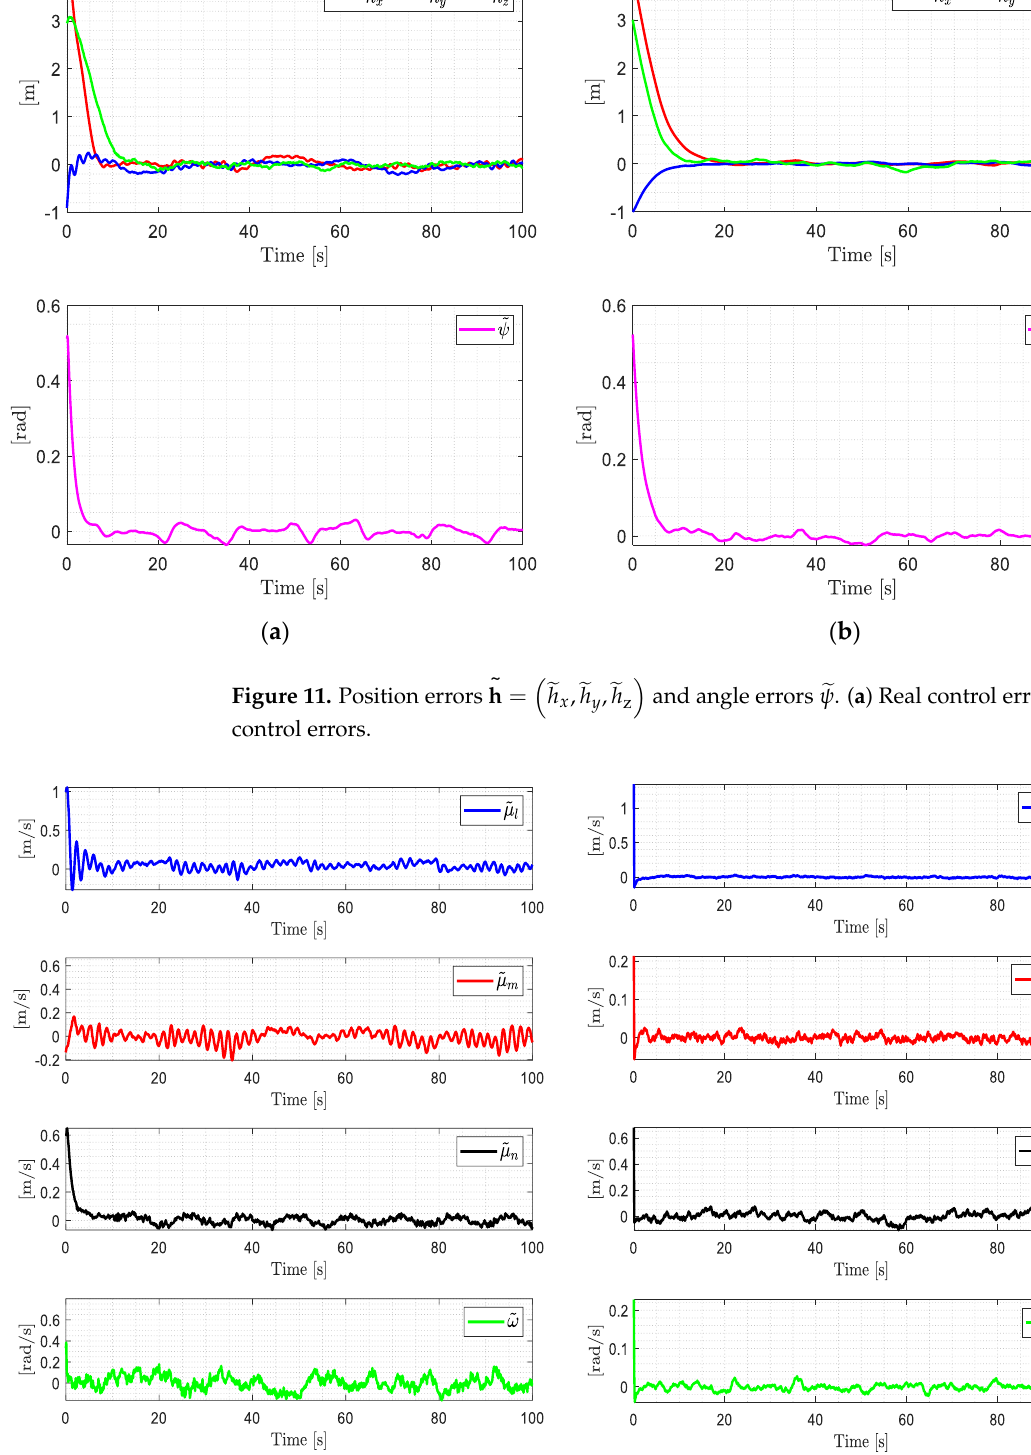
~ µ = ( = u ,u ,u , ω μ . ( a ) Real velocity errors; ( b ) Simulation veloc- l m n (cid:101) u l , (cid:101) u m , (cid:101) u n , (cid:101) ω ) . ( a ) Real velocity errors; ( b ) Simulation